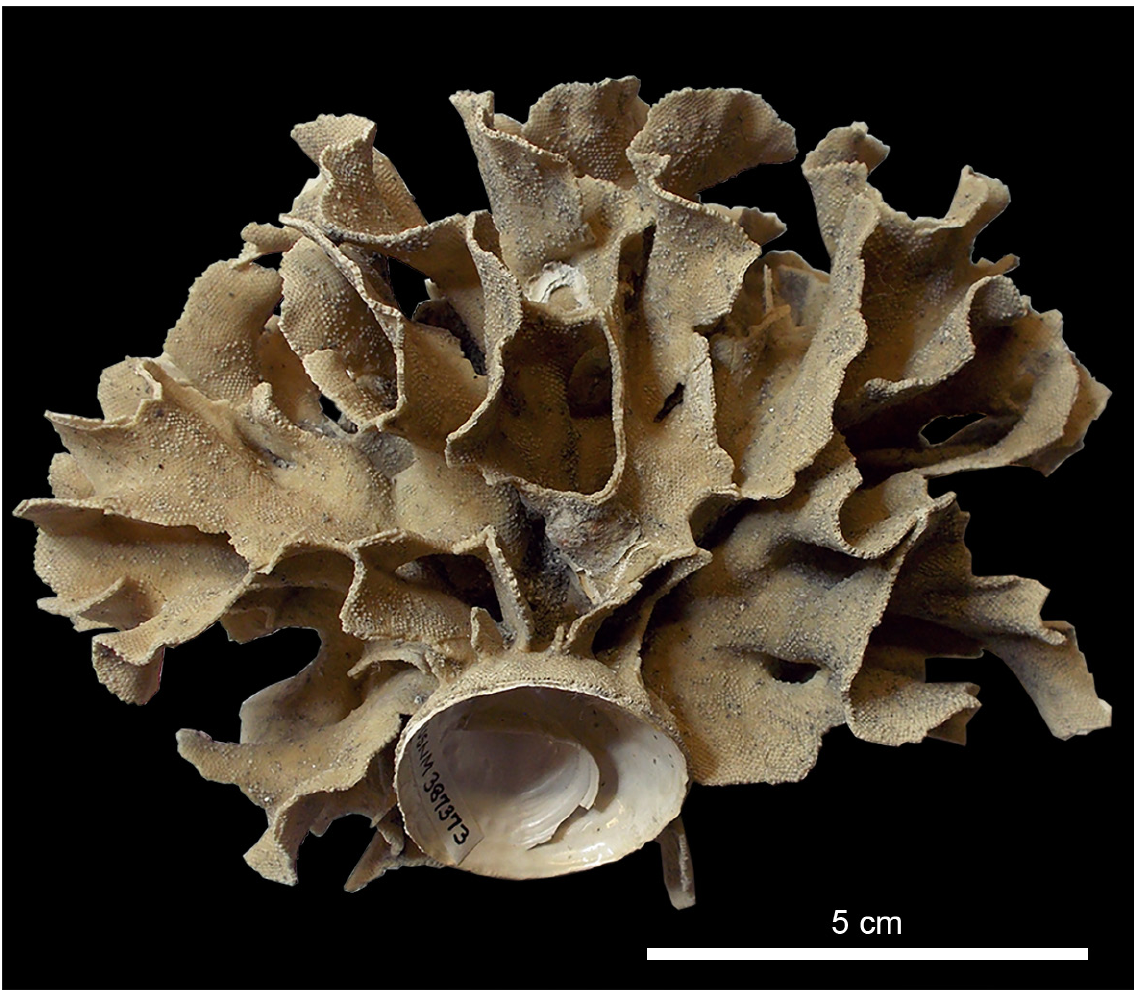
Fig. 2. Colony of Microporella tanyae sp. nov. USNM 387373, Pliocene, Yorktown Formation, Krause Pit, lower York County, Virginia, USA (Edgar Campbell